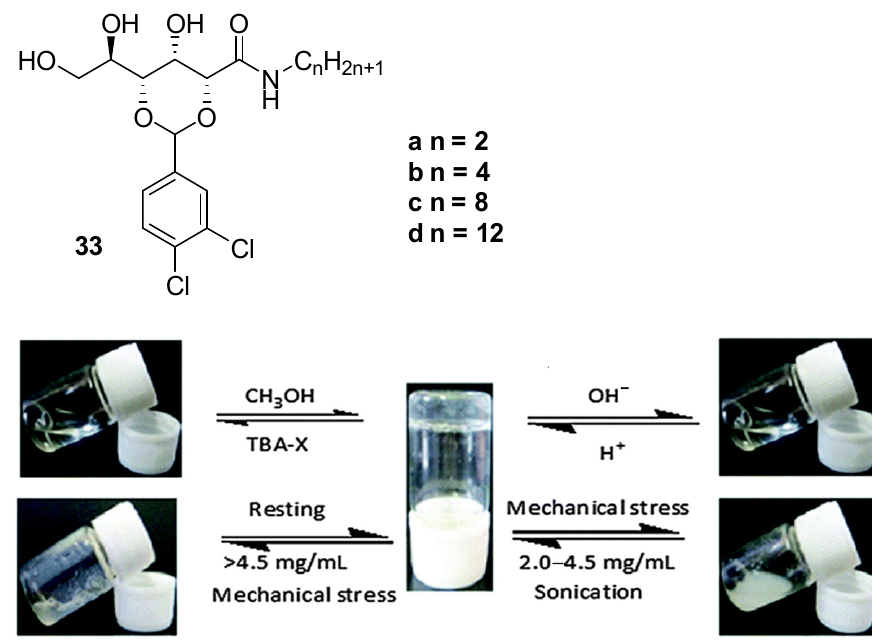
Figure 24 . D -gluconic acetal-based gelators 33 and their response to different stimuli. Adapted with permission from [69]. Copyright 2016 The Royal Society of Chemistry.